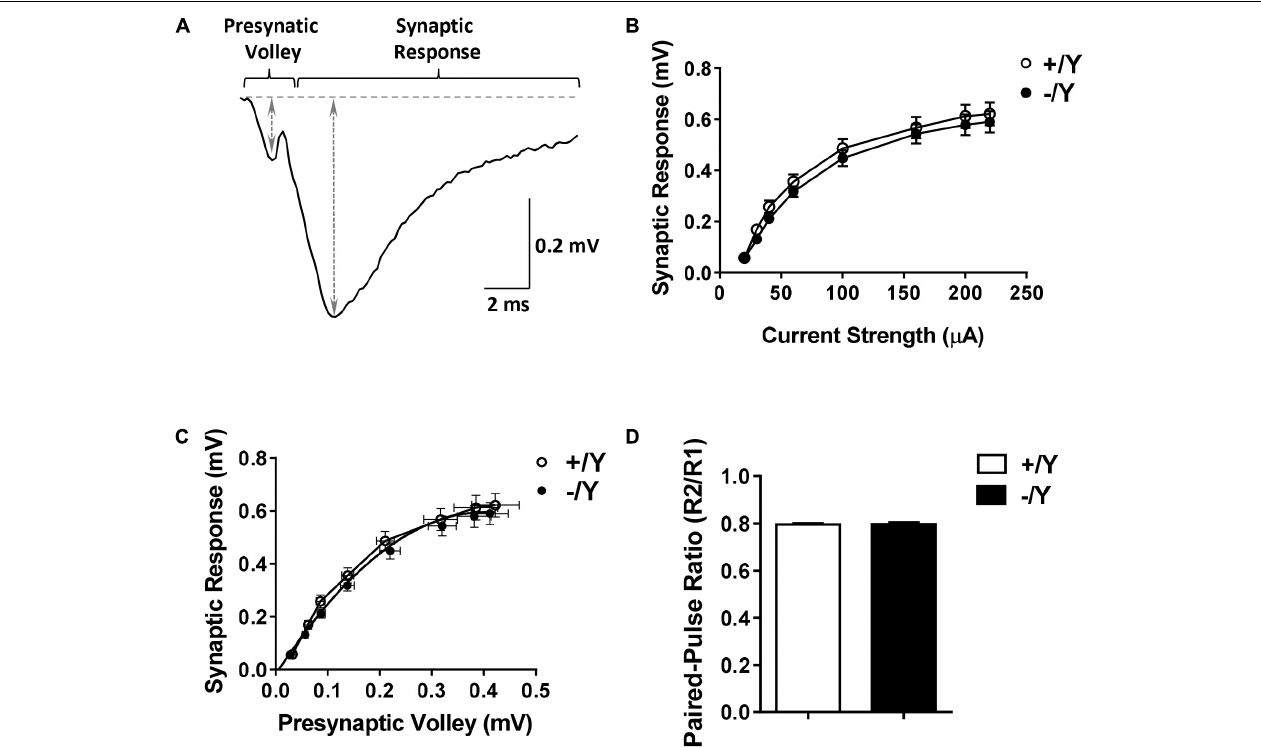
FIGURE 1 | Input-output relations and responses to paired-pulse stimulation in the perirhinal cortex (PRC) of Cdkl5 + /Y and Cdkl5 − /Y mice. (A) Example of the response evoked in layers II/III of the PRC by stimulation of layers II/III. The double-headed arrows indicate how the magnitude of the presynaptic volley and synaptic response were measured. (B) Magnitude of the synaptic response as a function of the stimulus strength in P50 Cdkl5 + /Y ( n = 16; 10 animals) and Cdkl 5 − /Y ( n = 21; 10 animals) mice. (C) Magnitude of the synaptic response as a function of the magnitude of the presynaptic volley. (D) Ratio of the synaptic responses (R2/R1) evoked by a pair of stimuli with an interpulse interval of 200 ms in P50 Cdkl5 + /Y ( n = 11; 9 animals) and Cdkl5 − /Y ( n = 9; 9 animals) mice. Values represent mean ±